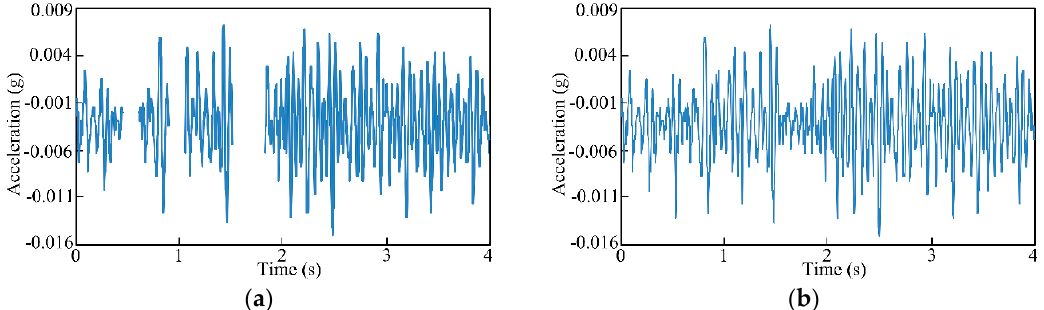
Figure 3. Data loss and reconstruction: ( a ) Data loss of 5%; ( b ) Data reconstruction result.